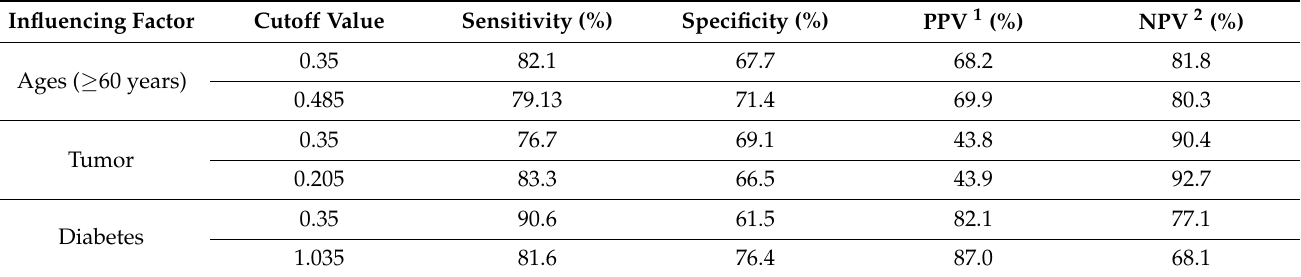
Table 7. Comparison of the diagnostic value of QFT-GIT after adjusting cutoff values. Influencing Factor Cutoff